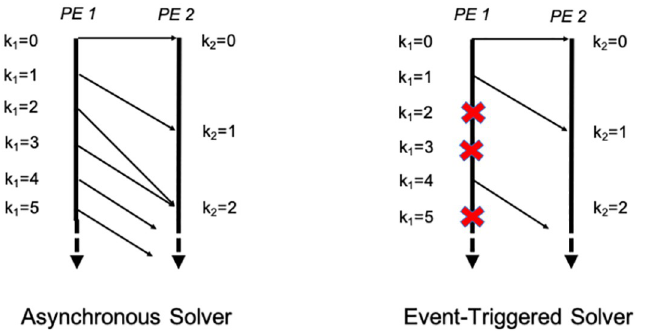
Fig 3. Comparison between asynchronous solver and event-triggered solver as illustrated using two PEs. The vertical axis is wall clock time. The asynchronous solver communicates at every iteration whereas the event-triggered solver communicates only when the event condition is satisfied. At other iterations, it avoids communication as shown by the red cross signs on the sender